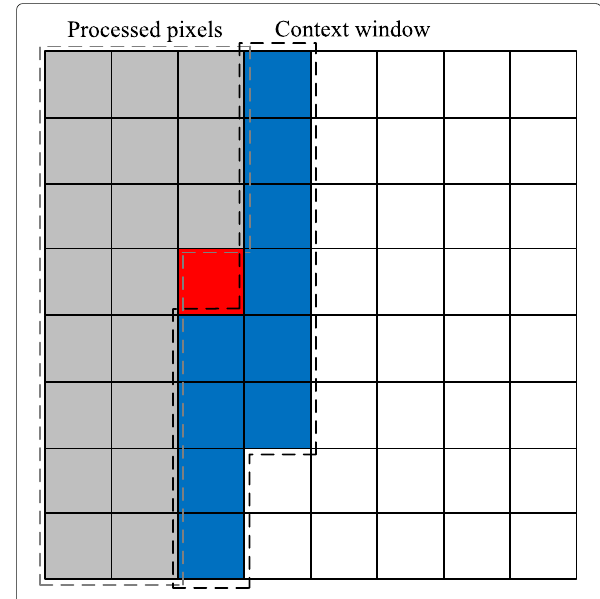
Fig. 7 An illustration of the context